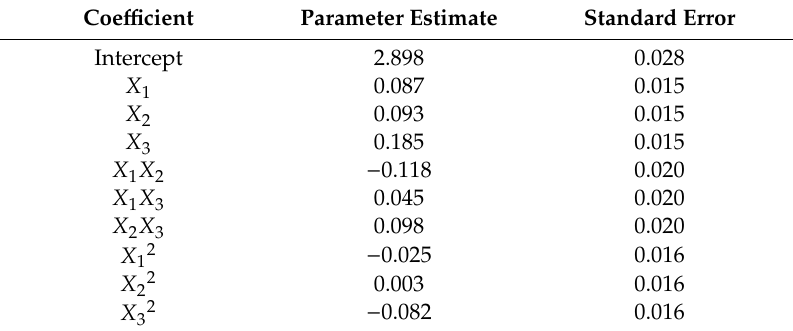
Table 5. Estimated regression coe ffi cients in the polynomial